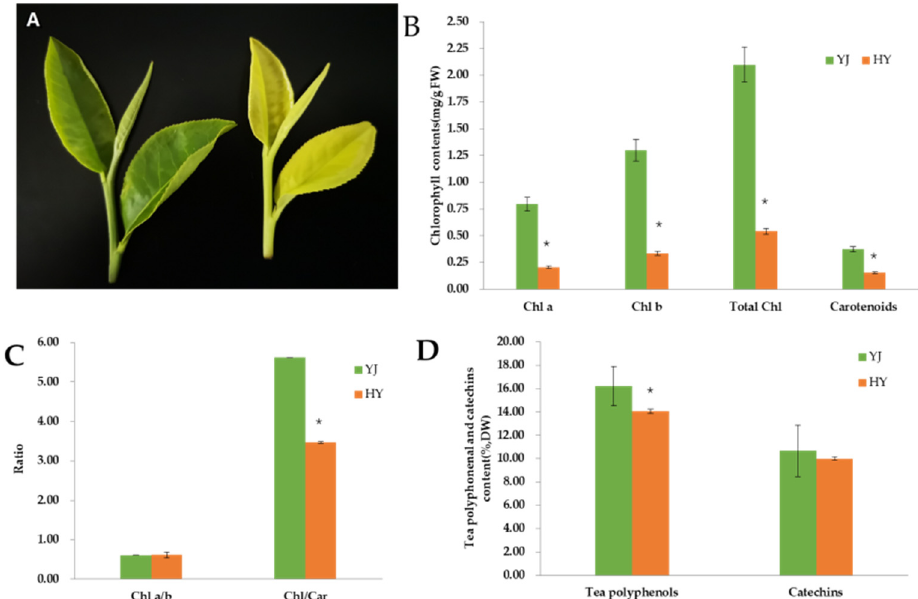
Figure 1. Phenotypic characteristics of Yinghong 9 ( left ) and Huangyu ( right ) ( A ) and pigment contents ( B – D ) of ‘Yinghong 9’ and ‘Huangyu’. The data are presented as the mean ± standard deviation ( n = 3). * indicates significant difference ( p < 0.05) between ‘Yinghong 9’ and ‘Huangyu’. YJ is ‘Yinghong 9’, HY is ‘Huangyu’.